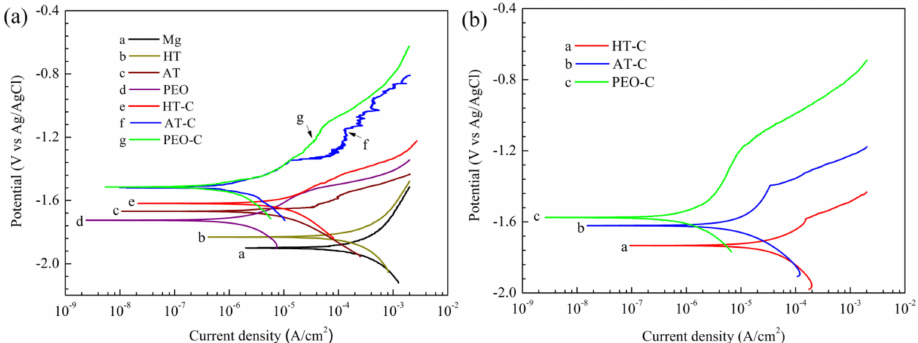
Figure 6. Potentiodynamic polarization curves of the pre-treated substrates and CaPh-coated samples in SBF at 37 ± 0.5 ◦ C: ( a ) pre-treated and CaPh-coated samples; ( b ) CaPh-coated samples after a 120-h immersion in